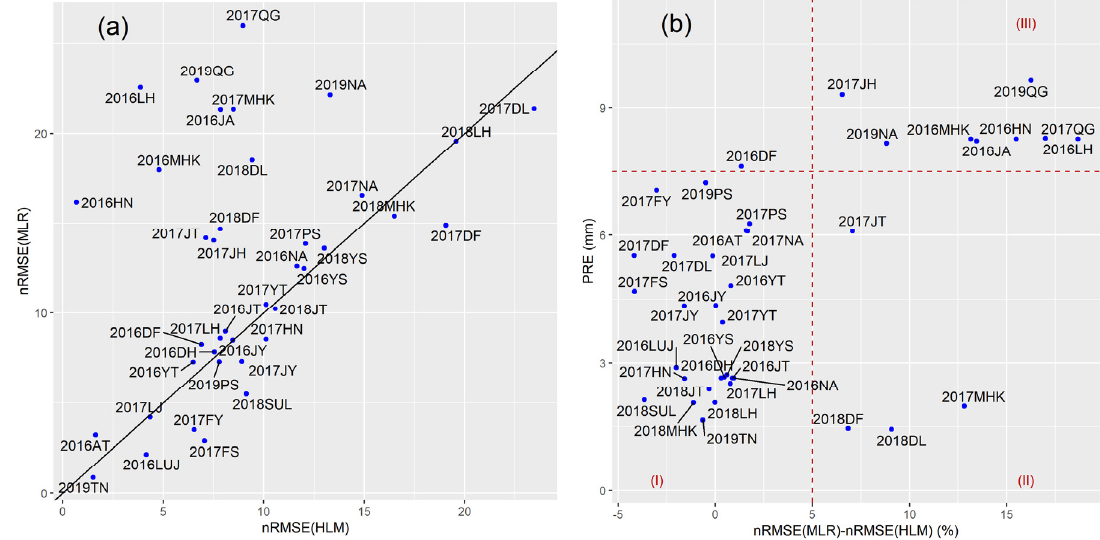
Figure 5. Relationship between the normalized root mean square error (nRMSE) of MLR and HLM, and precipitation. ( a ) The scatter diagram of nRMSE(MLR) and nRMSE(HLM) in different regions; ( b ) Relationship between PRE and difference between nRMSE(MLR)–nRMSE(HLM).